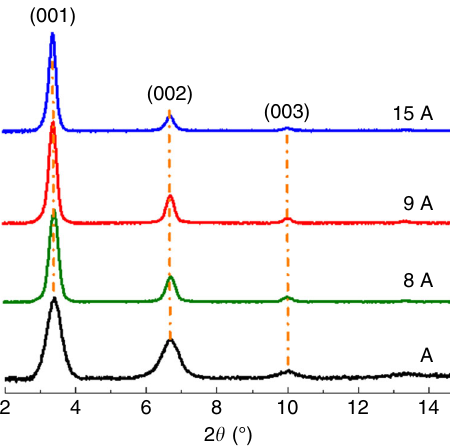
Fig. 3 Assembly of R-NDI(OEt) 2 in SURMOF-2 structures: out-of-plane XRD patterns of A, 8A, 9A, and